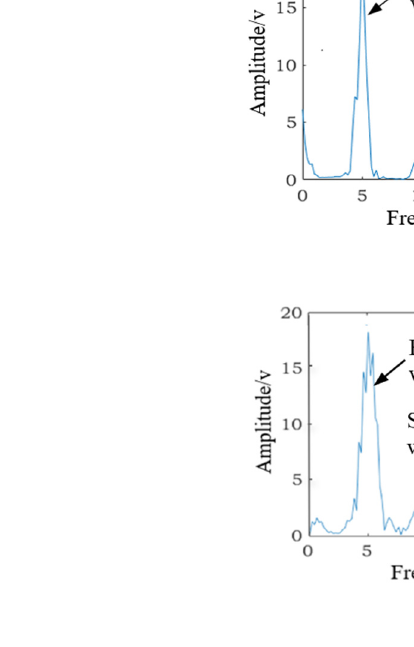
Figure 6. The SLM 316 L stainless steel specimen subjected to different fatigue cycles. ( a )The re ‐ ceived time ‐ domain signal subjected to 10,000 fatigue cycles. ( b ) The frequency spectra of the re ‐ ceived signal subjected to 10,000 fatigue cycles. ( c ) The received time ‐ domain signal subjected to 10,000 fatigue cycles. ( d ) The frequency spectra of the received signal subjected to 10,000 fatigue cycles .